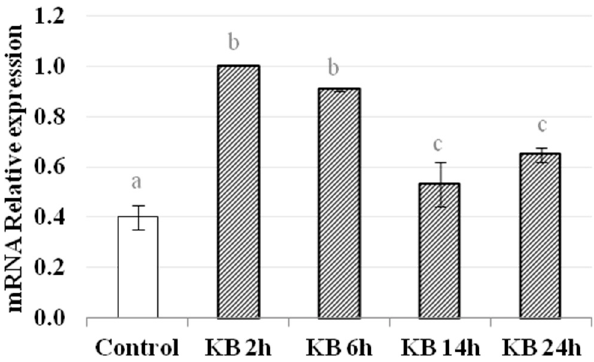
Figure 5. Real time PCR analysis of HO-1 mRNA expression in control HMEC-1 cells and cells treated with KB for 2, 6, 14 or 24 h. mRNA expression was normalized to the level of the housekeeping gene GAPDH. Data are the means ± SD of three independent experiments. Data not sharing a common letter are significantly different, p < 0.05.